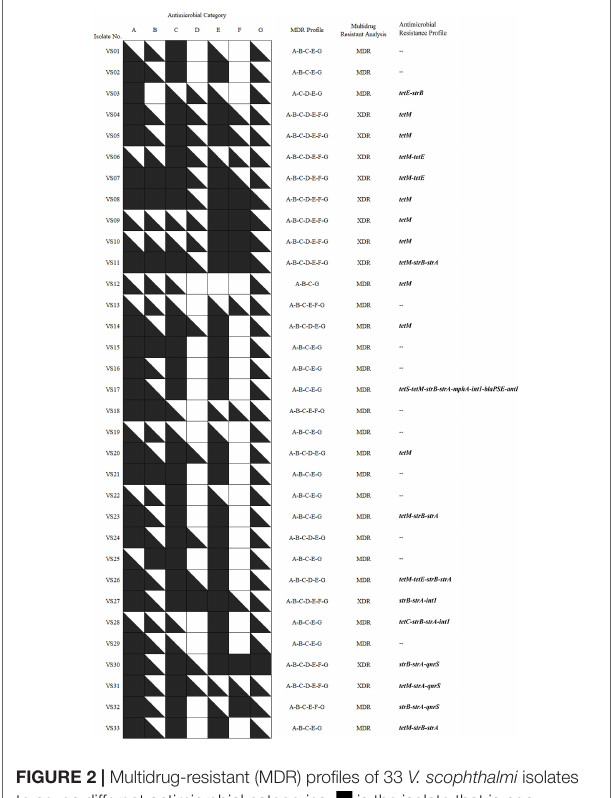
FIGURE 2 | Multidrug-resistant (MDR) profiles of 33 V. scophthalmi isolates to seven different antimicrobial categories.